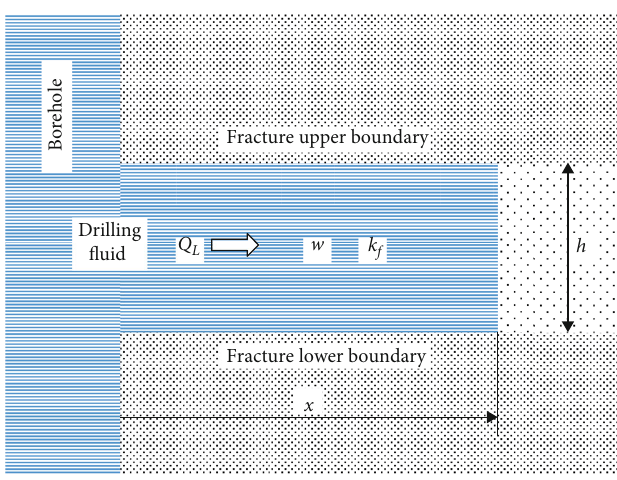
Figure 1: Cross-sectional view of liquid seepage in a fracture.